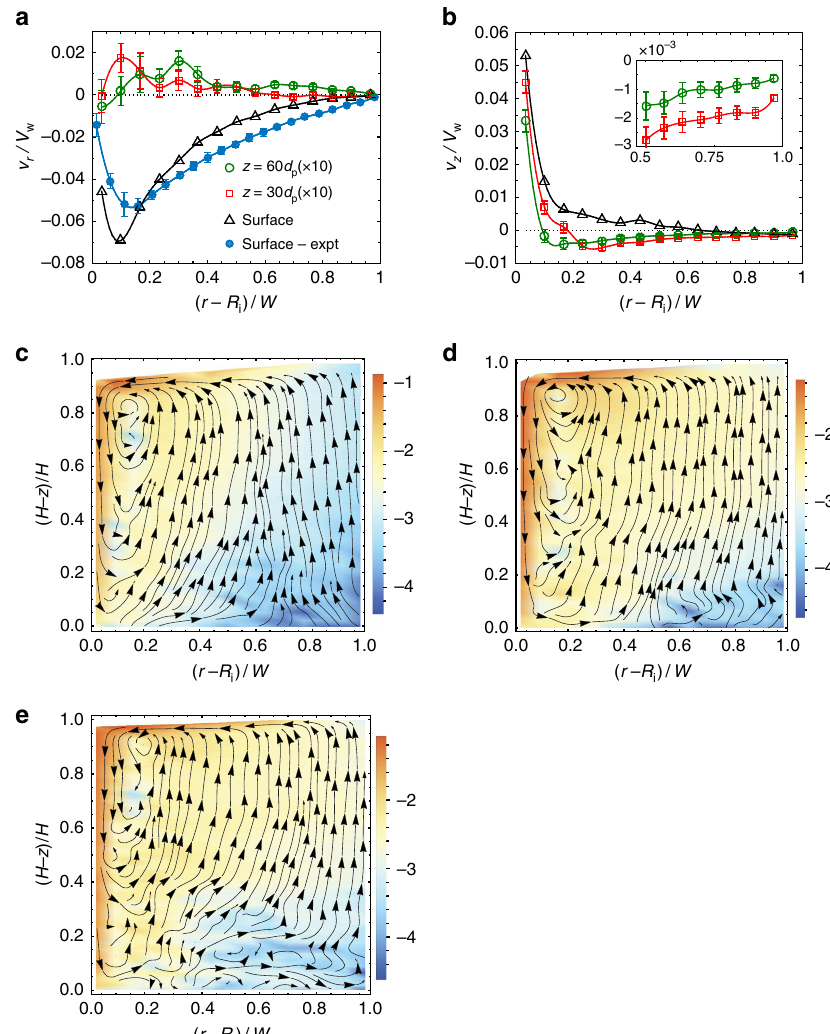
Figure 4 | The form of the secondary flow. ( a , b ) The velocities in the radial and vertical directions as a function of r at different z . The open symbols are DEM results for H ¼ 90 d p and the filled circles are experimental data. The error bars are obtained in the manner described in the caption of Fig. 2. ( c – e ) Streamlines of the secondary flow at steady state for fill heights H ¼ 30 d p ( c ), 60 d p ( d ) and 90 d p ( e ). The background colour indicates the value of (cid:2) (cid:3) 1 = 2 = V v 2 log 10 s , where s (cid:5) v 2 w is the magnitude of the secondary r þ z